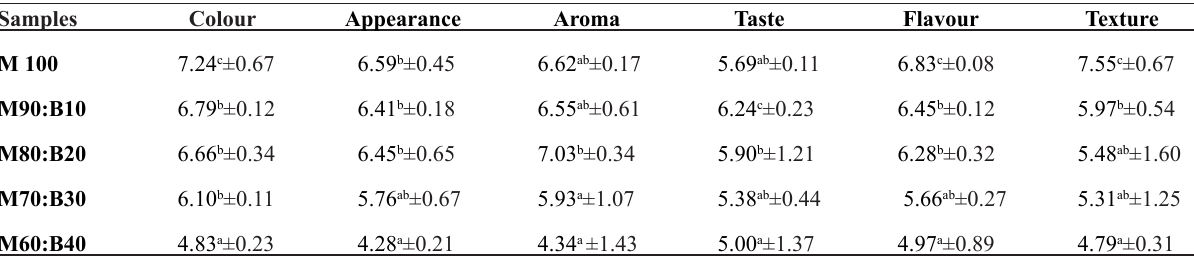
Table 6: Sensory Scores of Abari made from maize-bambara nut composite